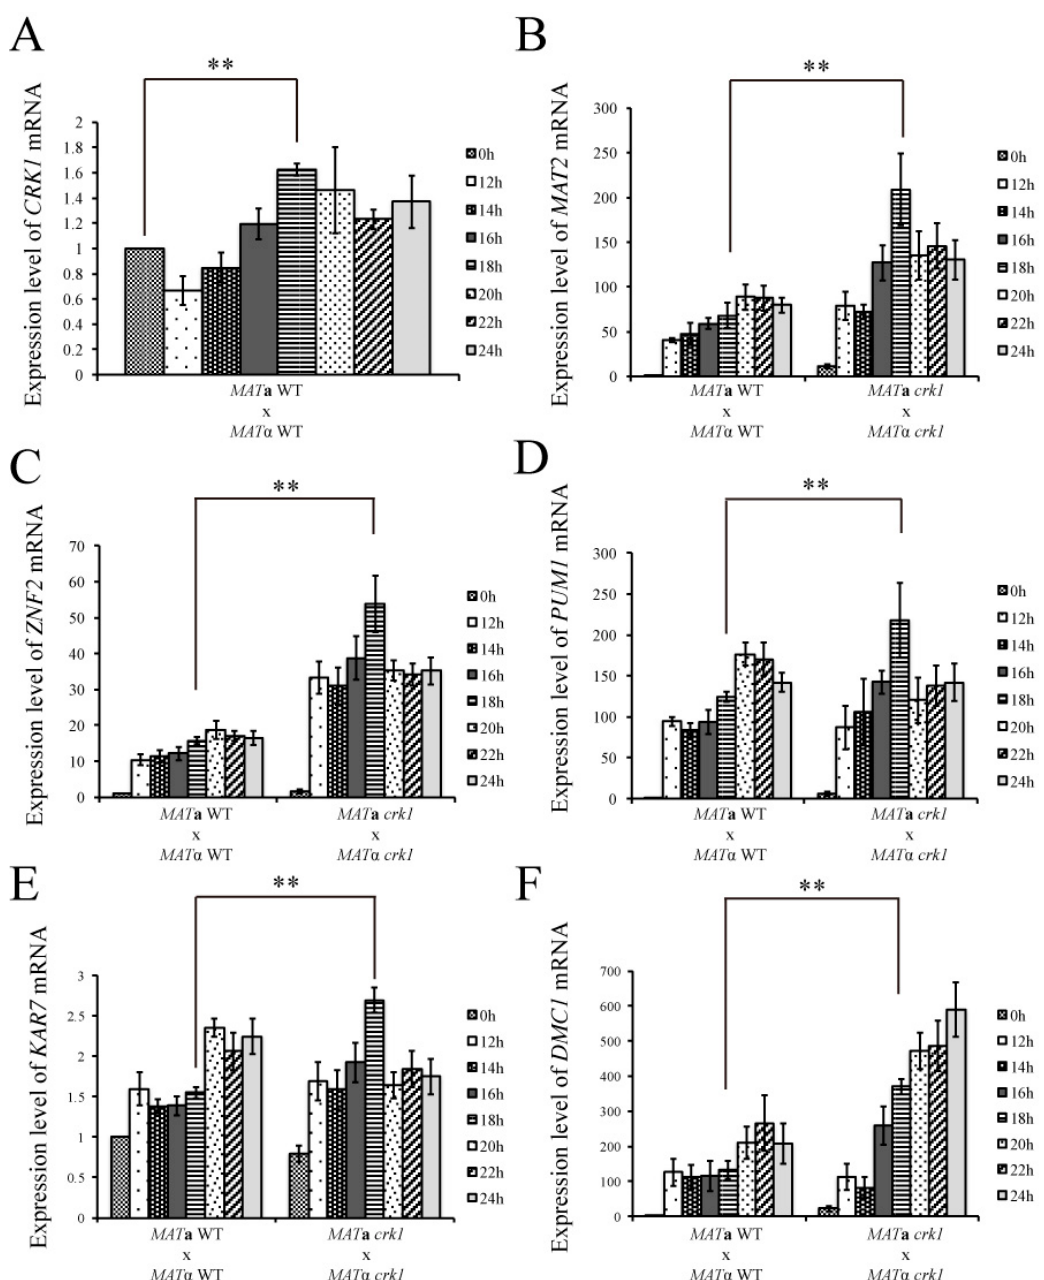
Figure 3. The expression of mating-, hyphal extension-and sporulation-related genes was elevated at 18 h in the bilateral crk1 mutant cross. Bilateral crosses involved the MAT a and MAT α wild-type and crk1 mutants were conducted on V8 agar plates and incubated at 26 ◦ C in the dark. Samples were collected at 0, 12, 14, 16, 18, 20, 22 and 24 h post-incubation. The expression of ( A ) CRK1 , ( B ) MAT2 , ( C ) ZNF2, ( D ) PUM1, ( E ) KAR7, and ( F ) DMC1 was examined by real-time qRT-PCR analysis. Triplicate reactions for each sample were conducted. Error bar represents the standard deviation from the mean of three replicates. The results were normalized to C. neoformans GPD1 expression. (** indicates p < 0.005).